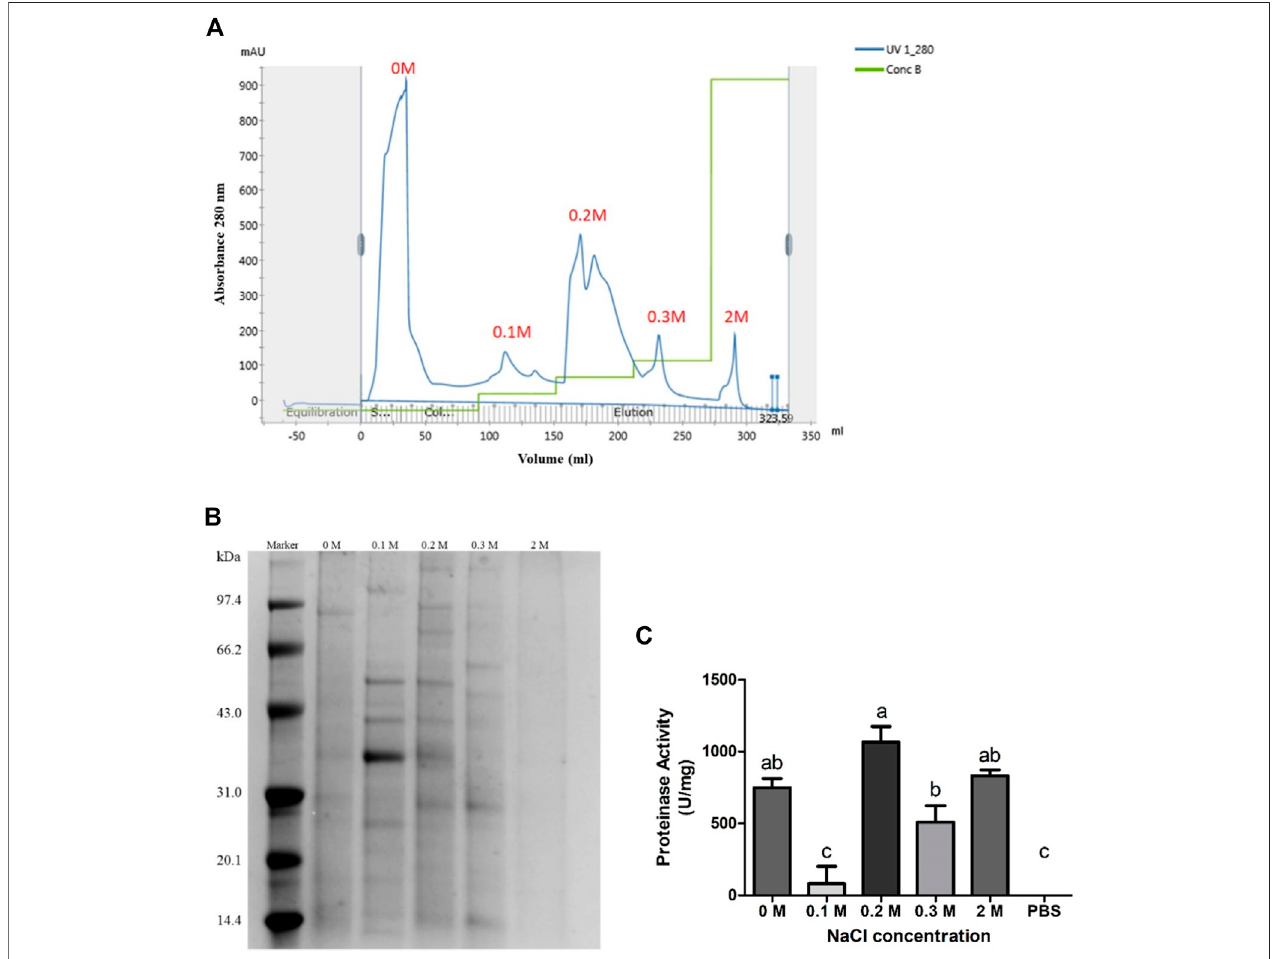
FIGURE3| DEAESepharoseFastFlowChromatographypuri fi cationofproteinfractionin80%ammoniumsulfatesaturation. (A) Elutionpeaksofproteinfractionin 80% ammonium sulfate saturation puri fi ed by DEAE Sepharose Fast Flow chromatography. Five independent peaks were obtained. (B) Nonreducing SDS-PAGE of each fraction. Fraction 0.1 and 0.2 M showed more clear protein bands. (C) Proteinase activity of each fraction. Four fractions showed signi fi cant proteinase activity, p < 0.05. Fraction 0.2 M showed the highest